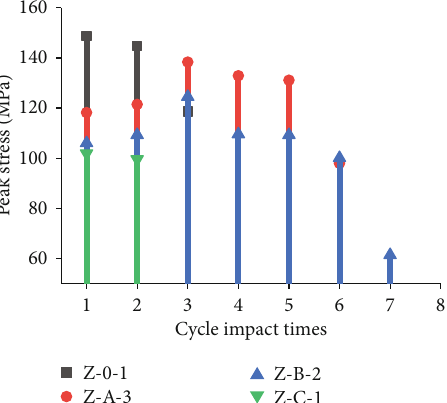
Figure 5: Dynamic stress-strain curve.